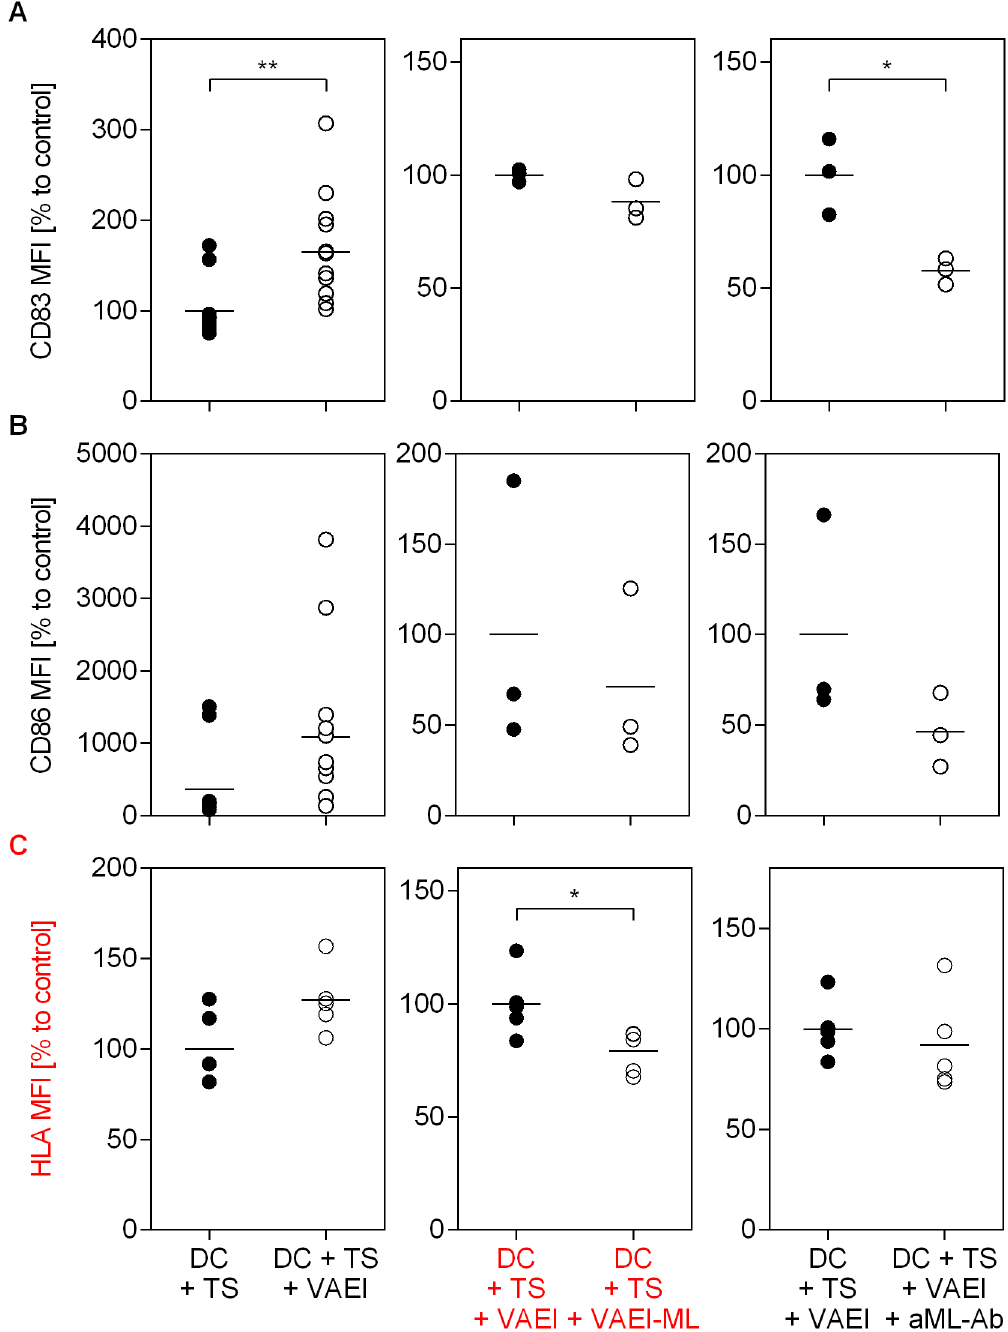
Fig 7. Impact of mistletoe lectins on the restoration of DC maturation with VAEI after tumor-induced immunosuppression. Dendriticcells derivedfrom CD14 + monocytes were incubatedwith 10% tumor supernatant (DC + TS). Further treatment of DC + TS was carried out with VAEI (DC + TS + VAEI; Iscador ® Qu Spez; 0.5 μ g/ml), ML-depleted VAEI (DC + TS + VAEI-ML; Iscador ® ;0.66 μ g/ml), or VAEI and anti-ML antibody(DC + TS + VAEI + aML-Ab; 2.5 μ g/ml). DC maturation was assessedby flow cytometric analysisof CD83 (A), CD86 (B) and HLA-DR (C) expression. MFI = Mean fluorescence intensity. Data and mean of 12 (DC + TS + VAEI), 3 (DC + TS + VAEI-ML and DC + TS + VAEI + aML-Ab) or 5 (HLA-DR) individualexperiments are presented in relationto stimulatedand TS- treated cells (DC + TS = 100%), or TS and VAEI-treated DC (DC + TS + VAEI = 100%). Asterisks indicatesignificant differences betweenthe groups ( * P < 0.05, ** P < 0.01, *** P < 0.001).